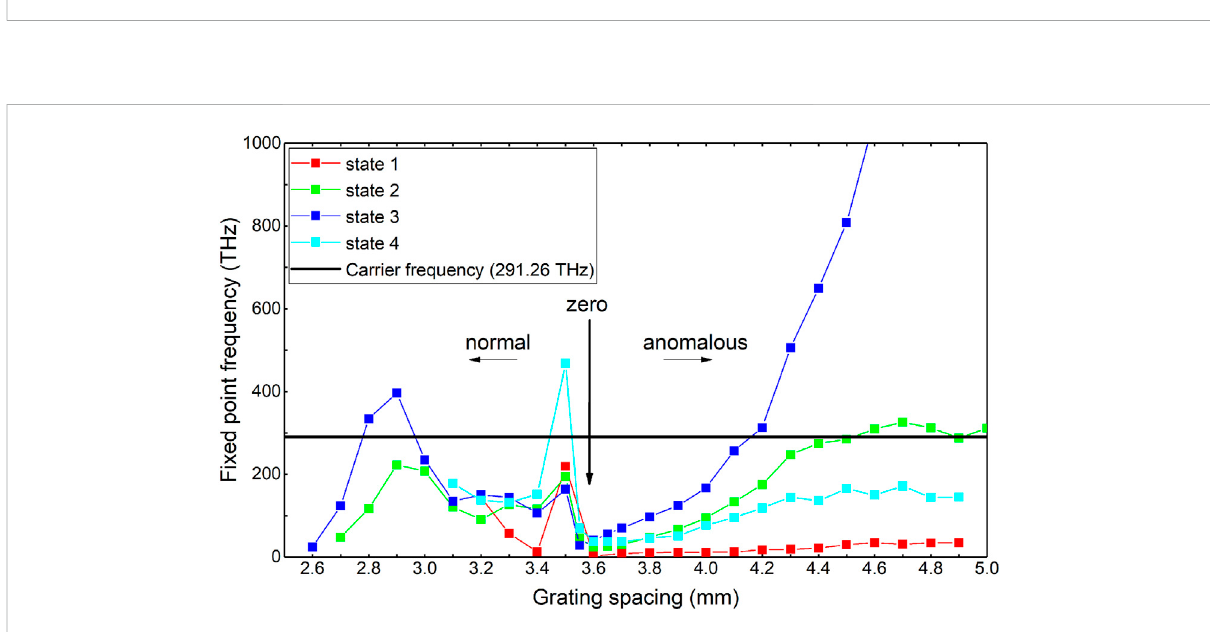
The pump power FPF versus net-cavity dispersion and intracavity polarization